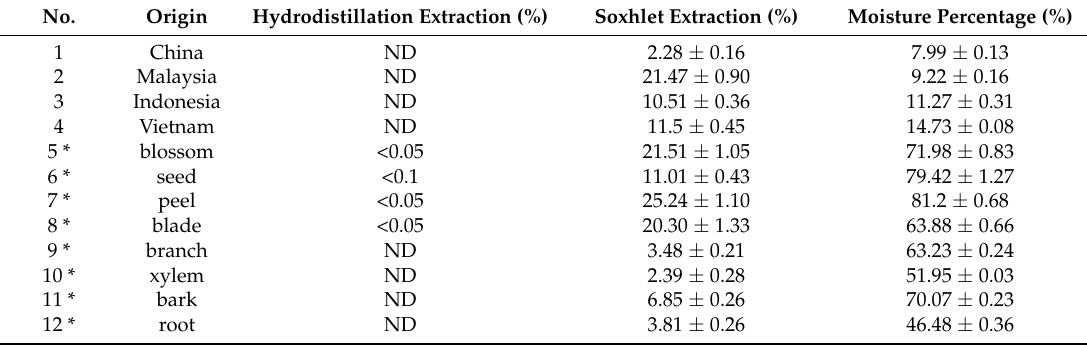
Table 1. Moisture analysis of A. sinensis organs and agarwood from different regions.